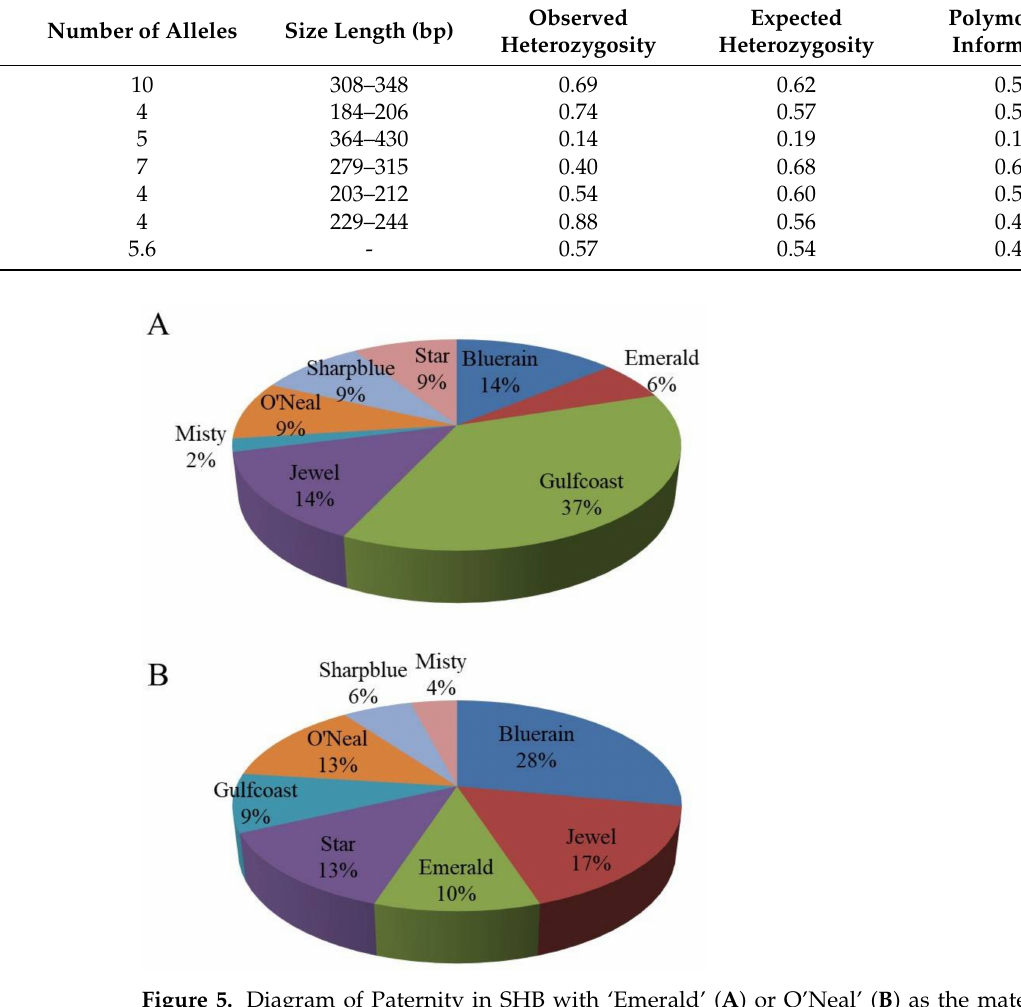
Figure 5. Diagram of Paternity in SHB with ‘Emerald’ ( A ) or O’Neal’ ( B ) as the maternal culti- var. Paternal preference statistics were performed with CERVUS 3.0 based on an SSR analysis of 132 seedlings of ‘Emerald’ and 78 seedlings of ‘O’Neal’. Paternity was determined with a positive LOD score (>3.0), and rejected with a negative LOD score ( − 3.0 or less). Candidate fathers were then assigned to the clusters at 95%